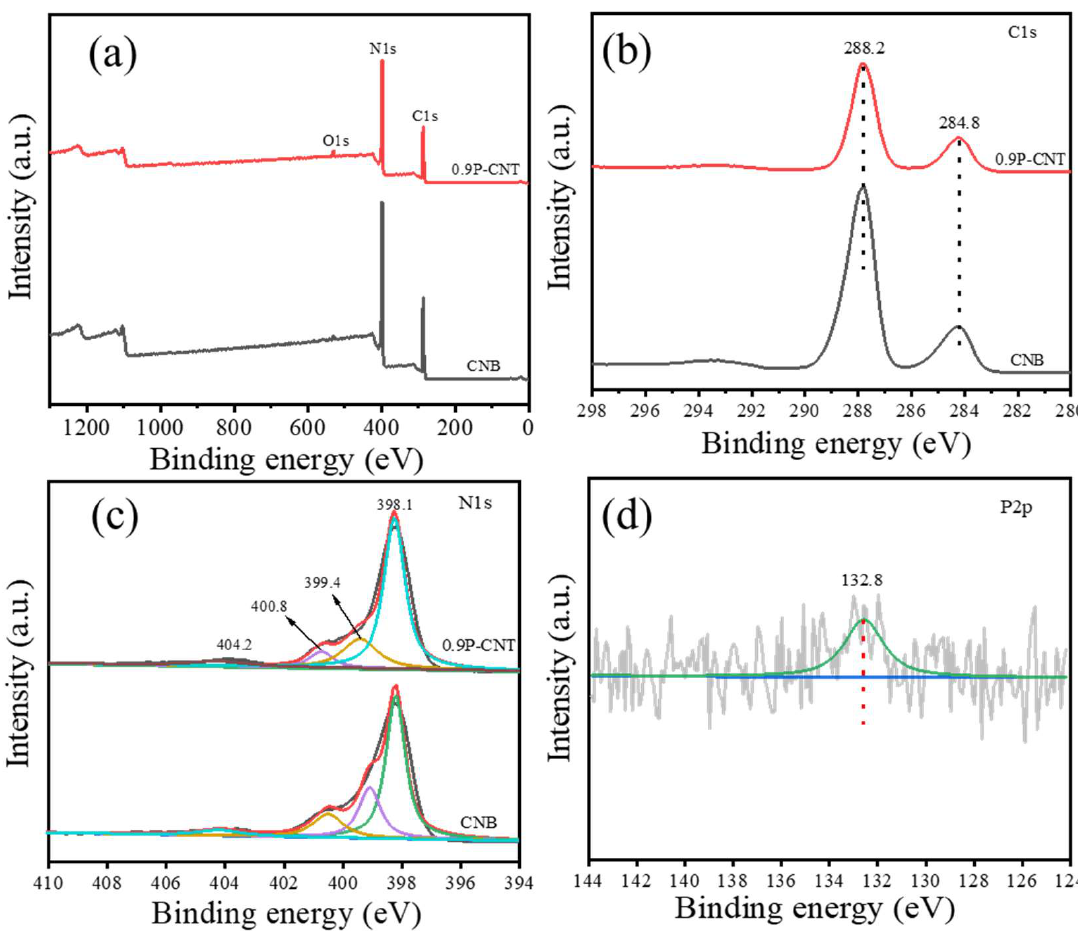
Figure 6. The XPS survey spectra of the as-prepared CNB and 0.9P-CNT samples ( a ), and high- resolution XPS spectra of CNB and 0.9P-CNT in different regions. ( b ) C1s, ( c ) N1s, and ( d ) P2p.